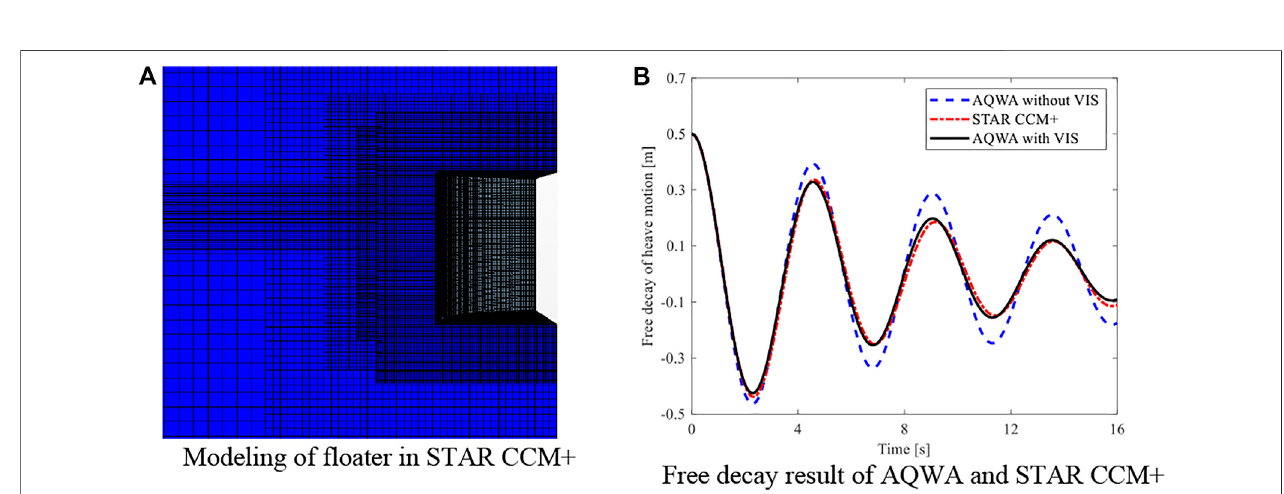
FIGURE 7 | Investigation of viscous damping correction. (A) Modelling of the fl oater in STAR CCM+. (B) Free decay result of AQWA and STAR CCM+.